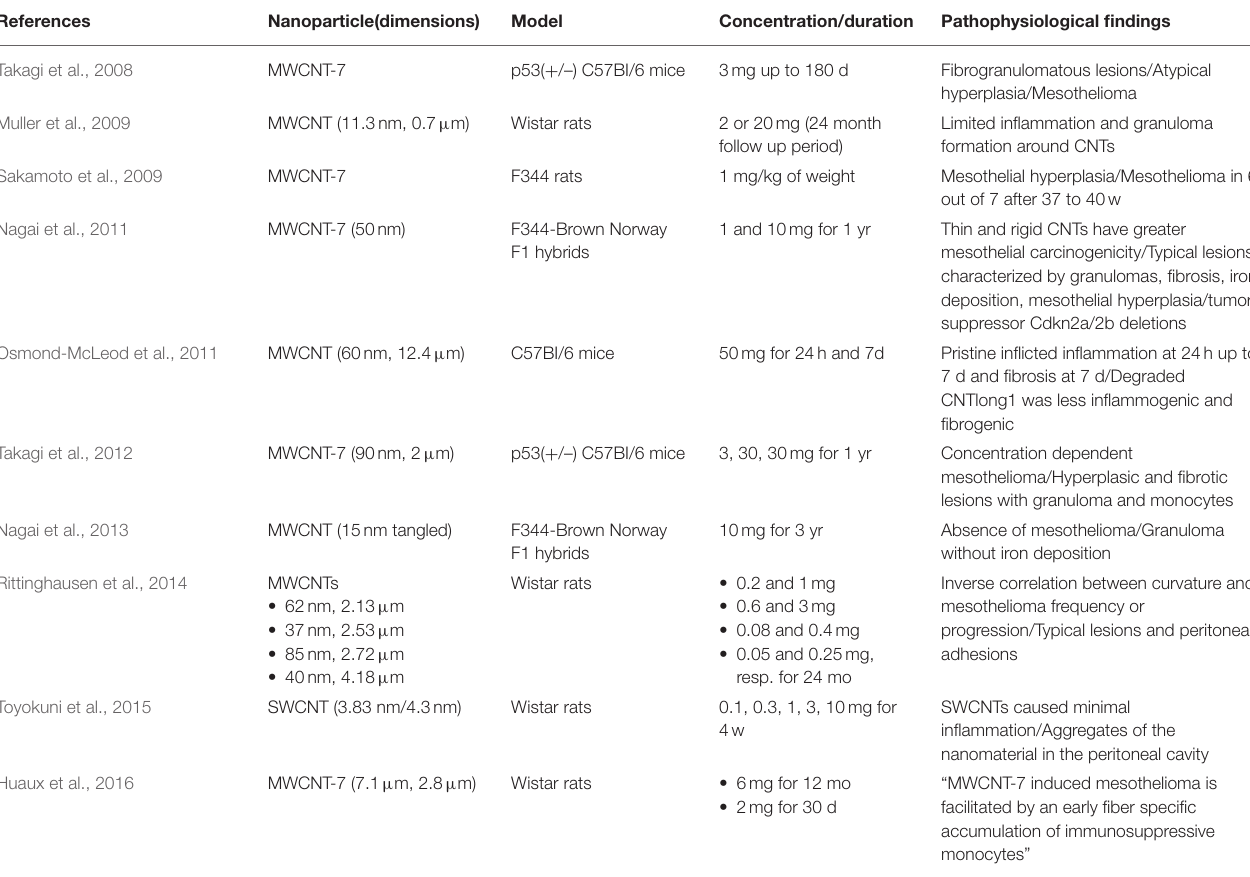
TABLE 3 | Studies of intraperitoneal injection of CNTs (day = d, month = mo, year =